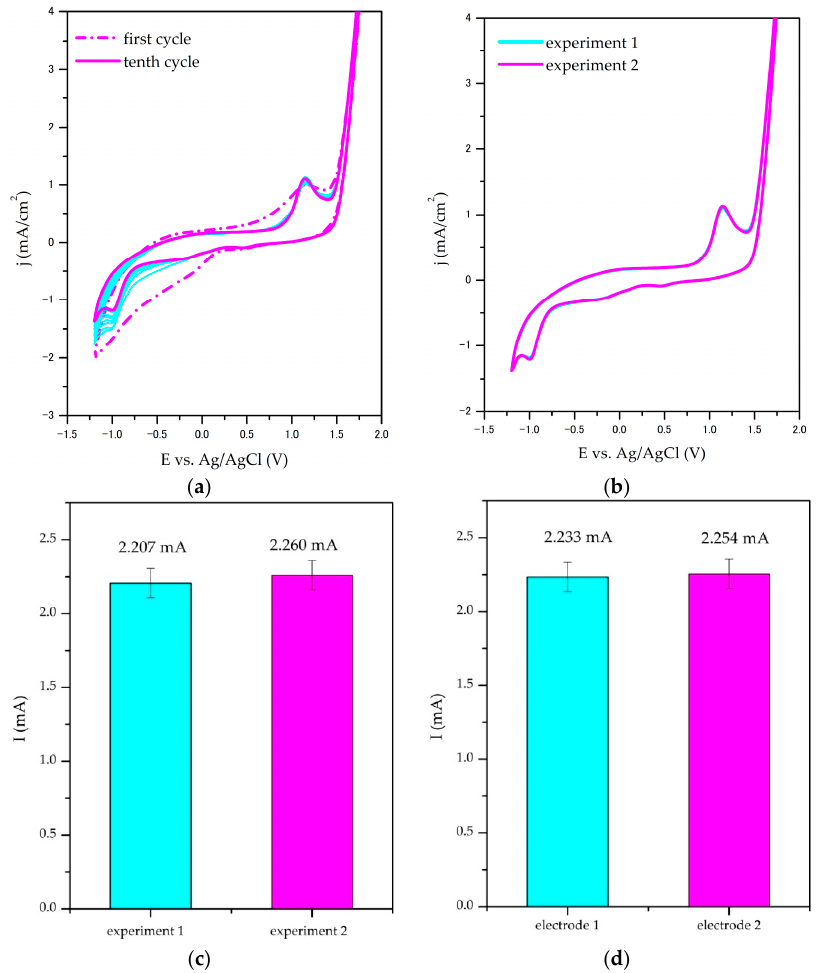
Figure 5. Stability, repeatability and reproducibility studies of SnO 2 /GNP@SS electrode: ( a ) cyclic stability; ( b ) repeatability—cyclic voltammograms of two individual experiments with the same electrode; ( c ) repeatability—peak currents comparison; ( d ) reproducibility—comparison of peak currents obtained with two independent